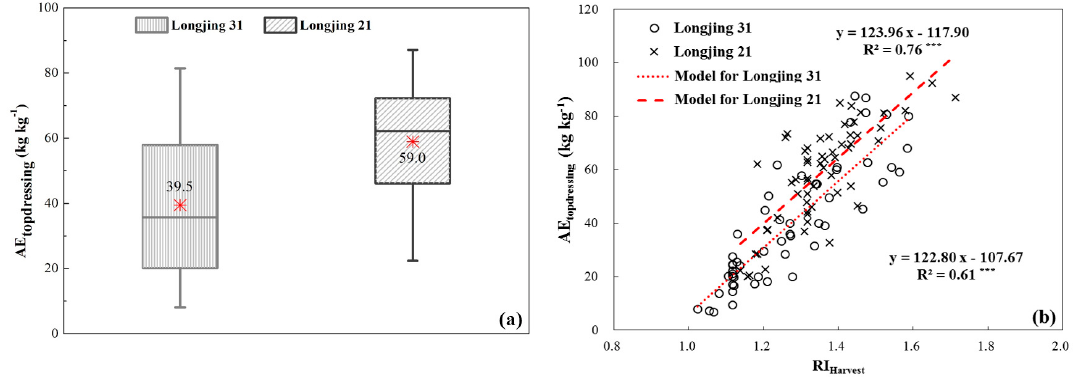
Figure 5. The difference in AE topdressing between Longjing 31 and Longjing 21 ( a ) and its relationship with RI Harvest ( b ). The red ✳ indicates the average of AE topdressing in Figure 5a. The red lines are the different regression models for Longjing 31 and Longjing 21 in Figure 5b; *** indicates significance at the level of p < 0.001.